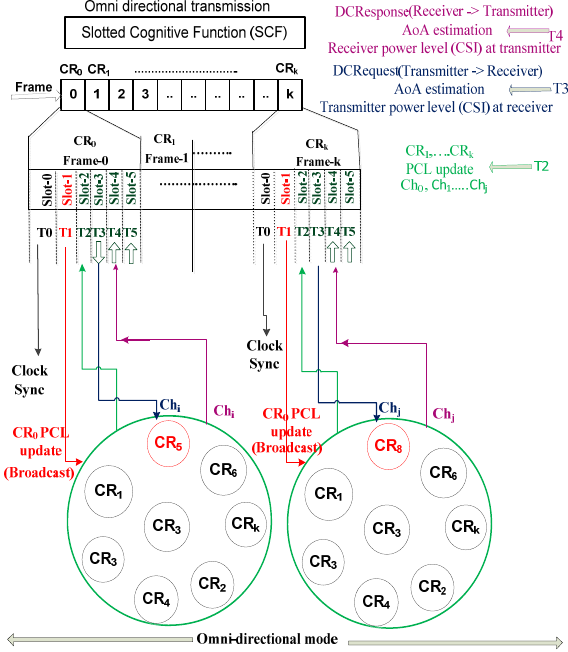
Figure 4. Operation of Slotted Cognitive Function